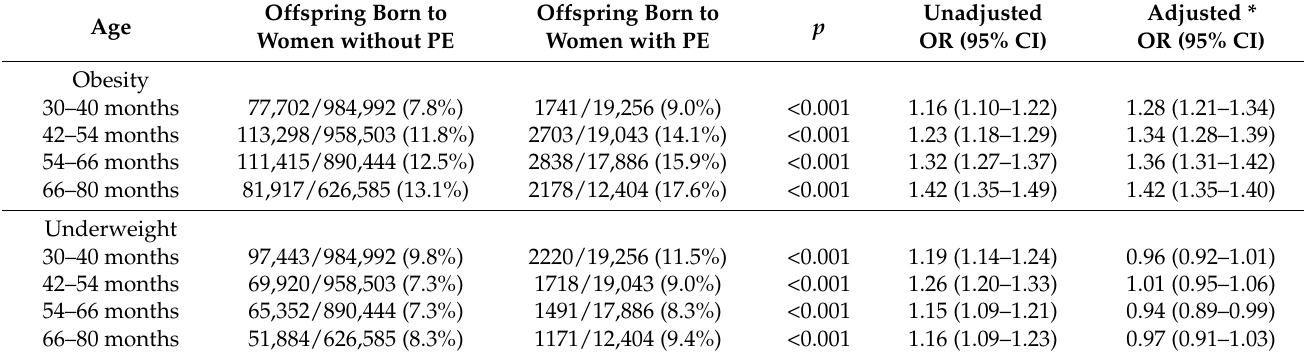
Table 3. Prevalence and associations between maternal history of preeclampsia (PE) and underweight and obese offspring until 80 months of